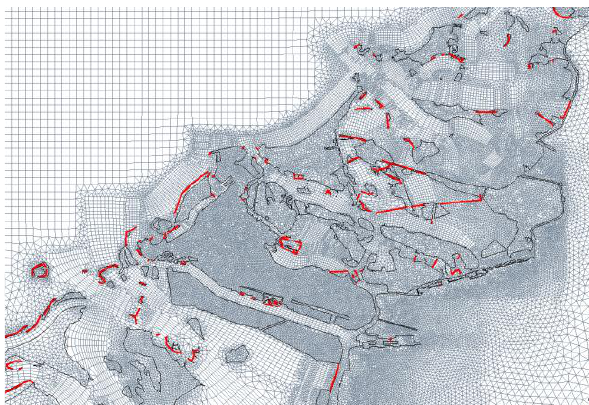
Figure 2. DELFT3D AGM Gulf model unstructured grid.